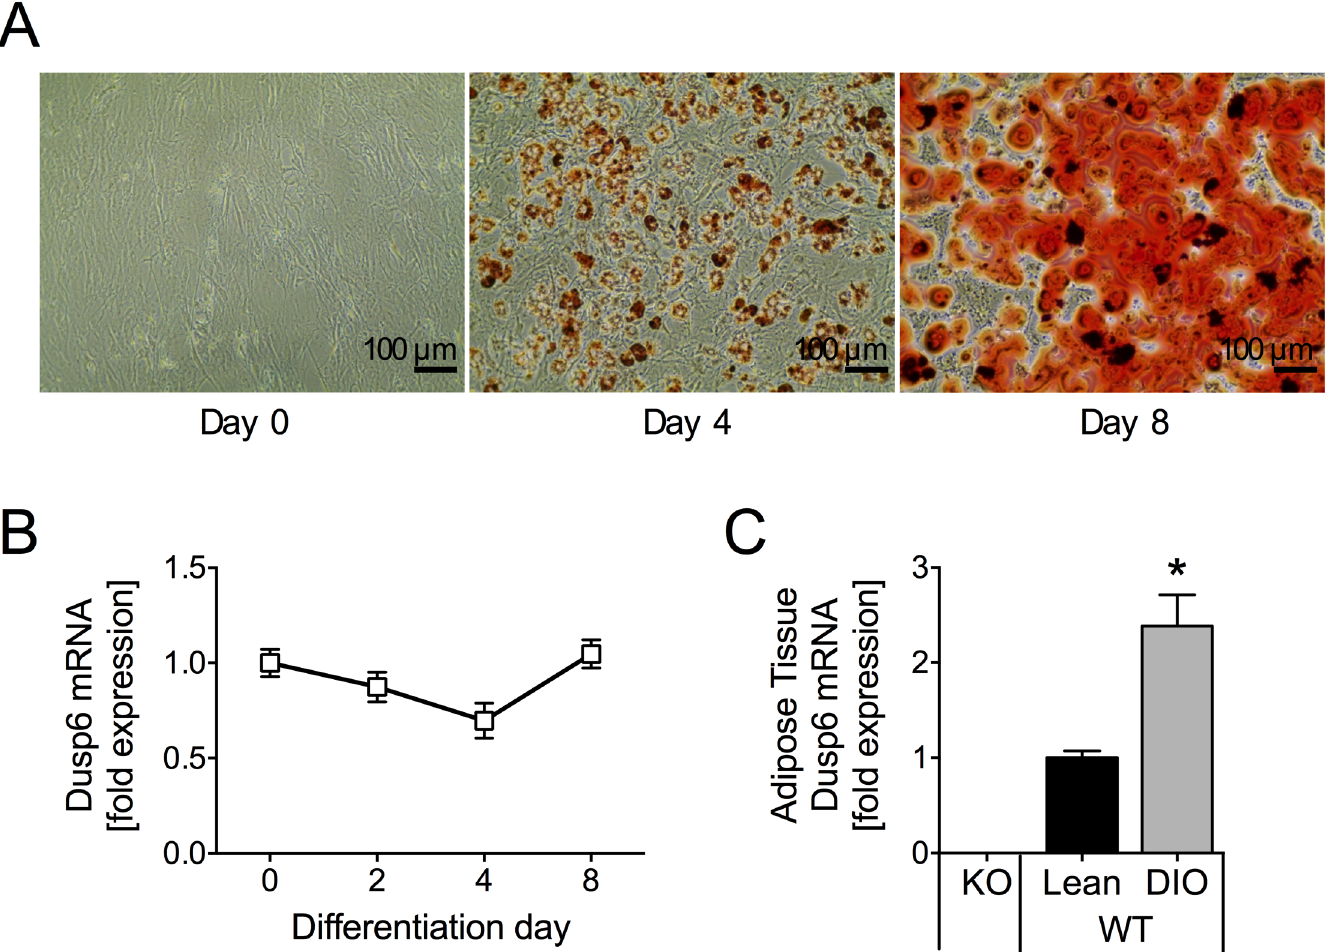
Fig 2. Diet-induced obesity increases Dusp6 expressionin eWAT. Primary pre-adipocytesisolated from inguinalWAT of C57Bl/6Jmice undergoing differentiationto mature adipocytesdisplayedincreasedtriglyceridecontent (A; representative images Oil Red O staining), but unchanged Dusp6 mRNA levels (B; two independentwells from two cell preparations). Dusp6 mRNA was absent in epididymal WAT of HFD-fed DUSP6 KO mice, and increasedin HFD-fed obesecompared to chow-fedlean C57Bl/6Jmice (C; n = 3–8). Means ± SEM, * p < 0.05.